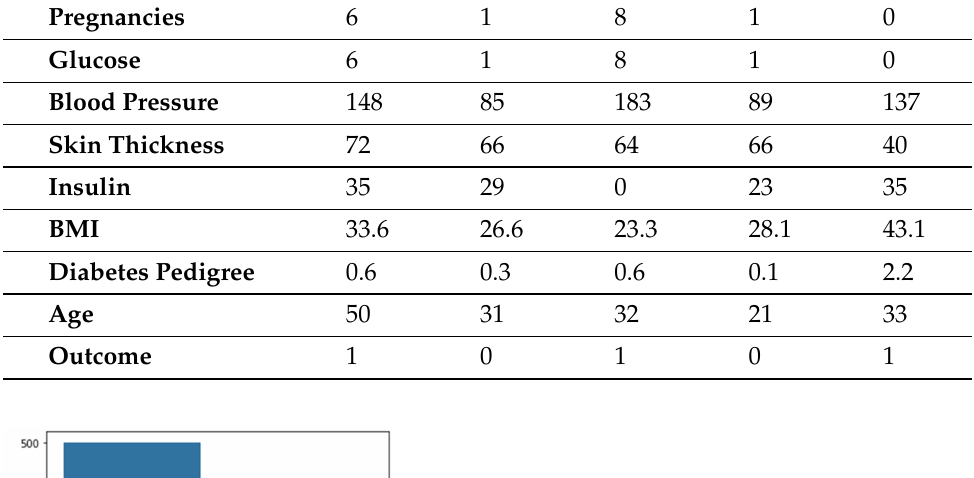
Table 1. A sample from the database.